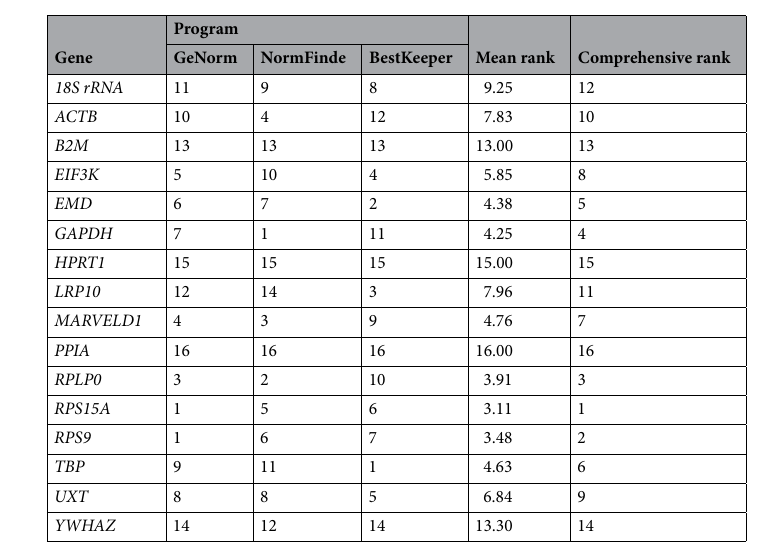
Table 4. Stability ranking of candidate reference genes during induced differentiation of bovine SMSCs analyzed by the three combined algorithms.